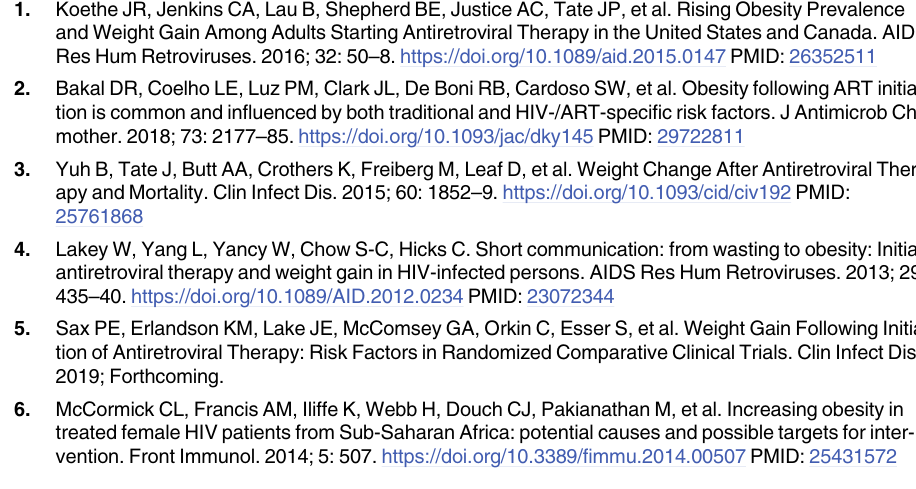
S1 Fig. Example of antagonism response curve for INSTI EVG. EC antagonism assay illustrated for EVG and positive control (SHU9119). S1 Table. Biochemical binding assay. S2 Table. Human C values for approved INSTIs at recommended clinical max